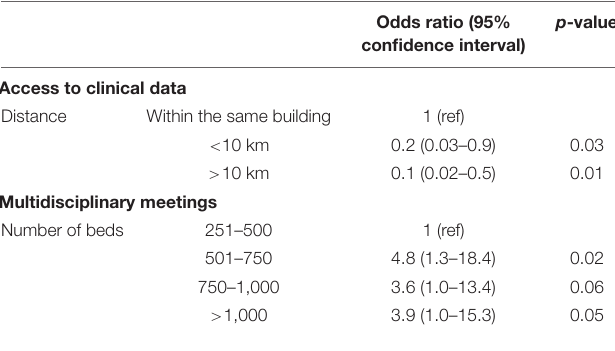
TABLE 4 | Association between distance of the hospital and access to clinical data and between hospital size and multidisciplinary meetings.